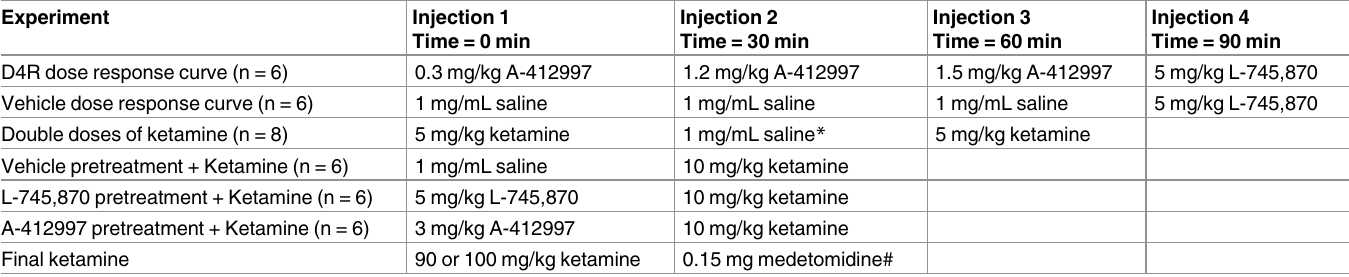
Table 1. Time course of